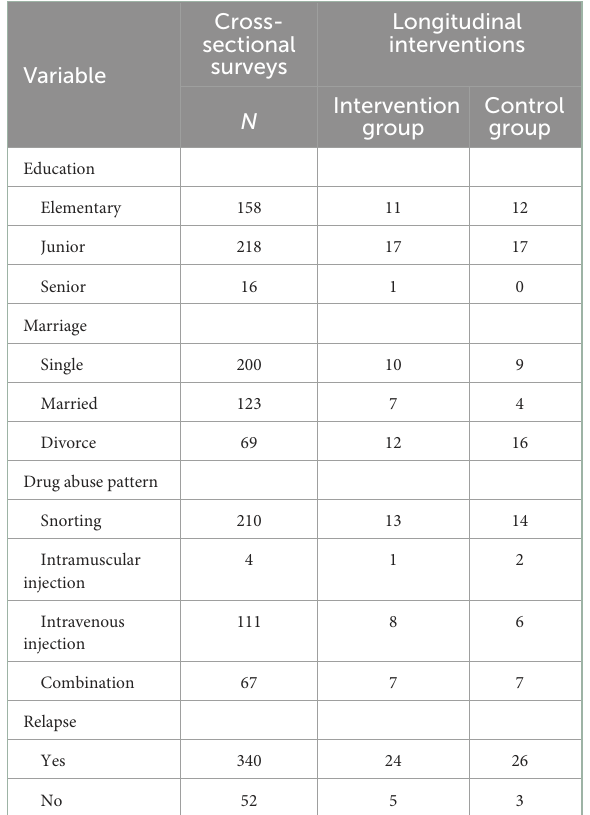
TABLE 1 Descriptives of the